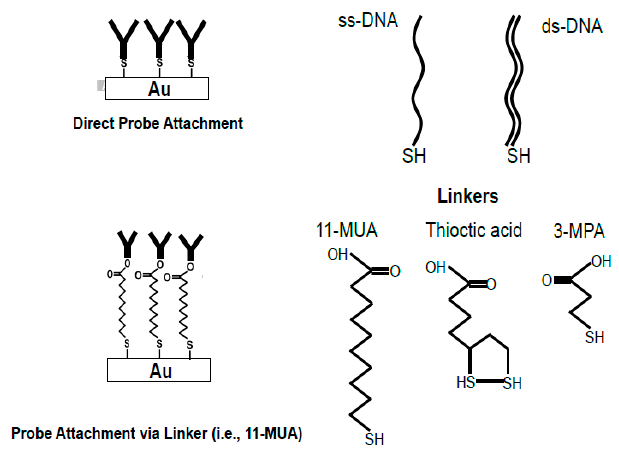
Figure 1. Direct and indirect attachment of molecules onto gold surfaces.